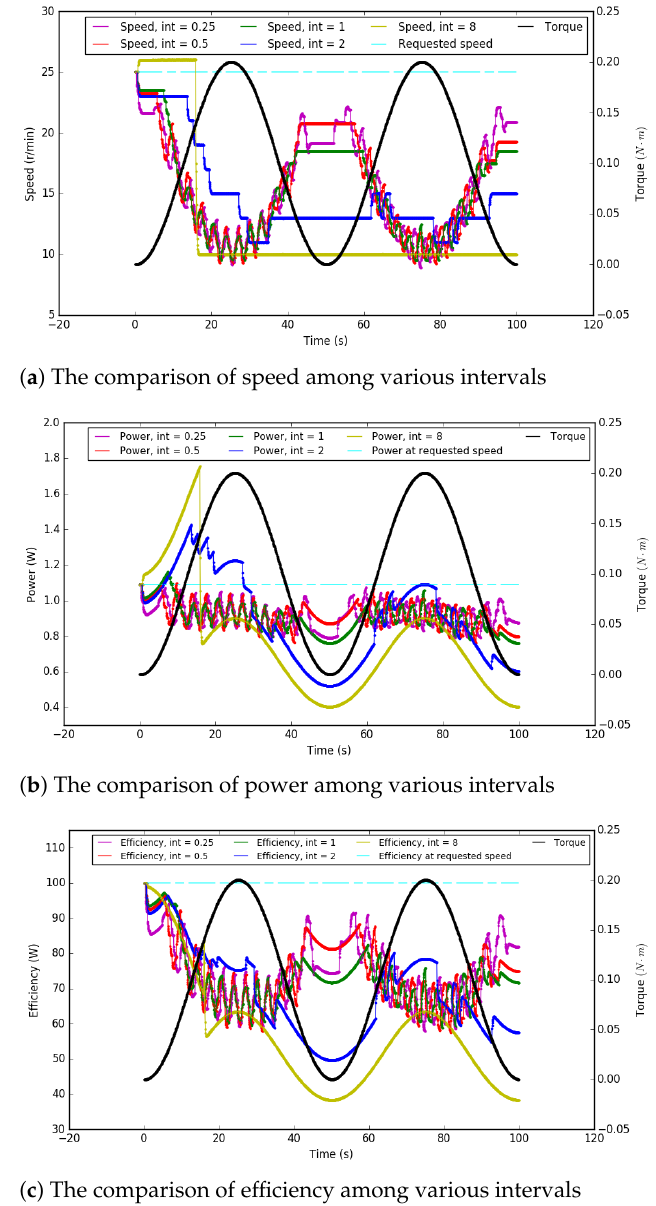
Figure 10. Performance comparisons among various